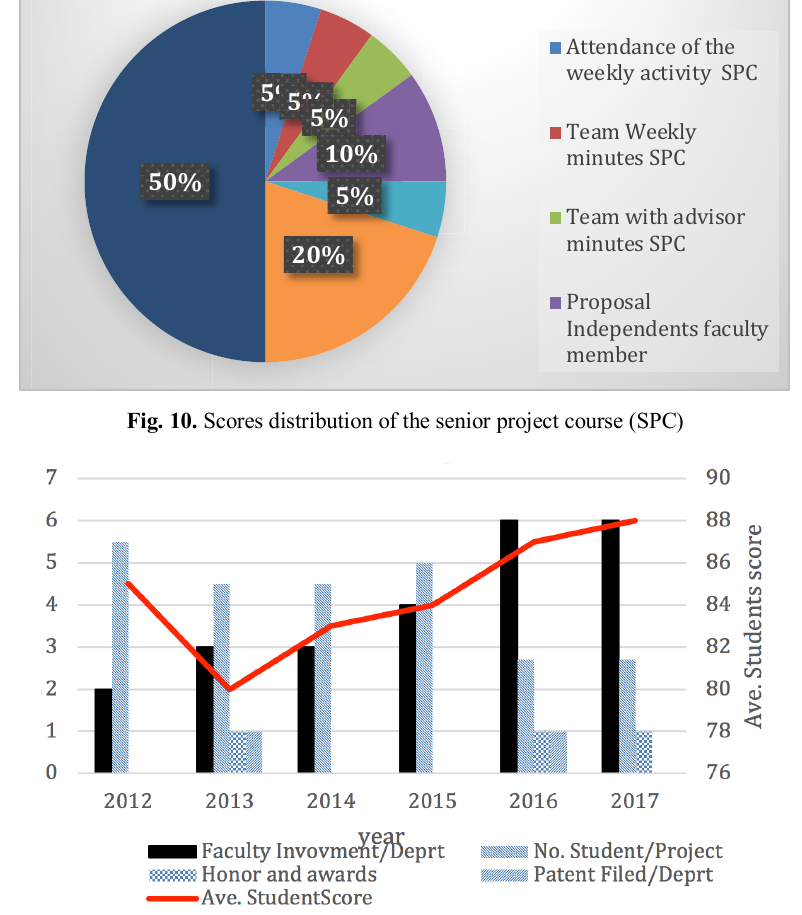
Fig. 11. Evaluation of the Impeded Aspect of SCDP on Students Performance of departments